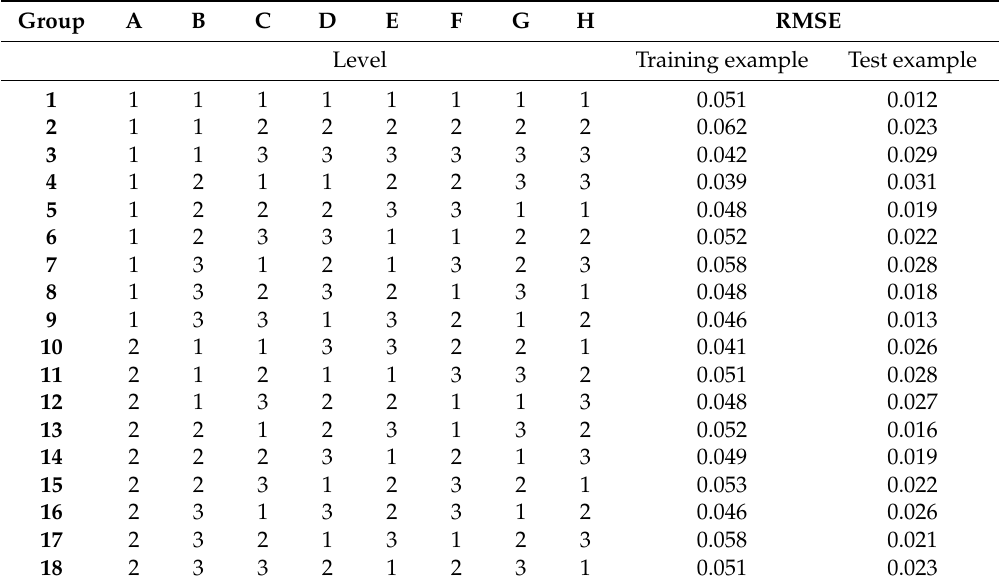
Table 2. Fast messy genetic algorithm (fmGA) training and test